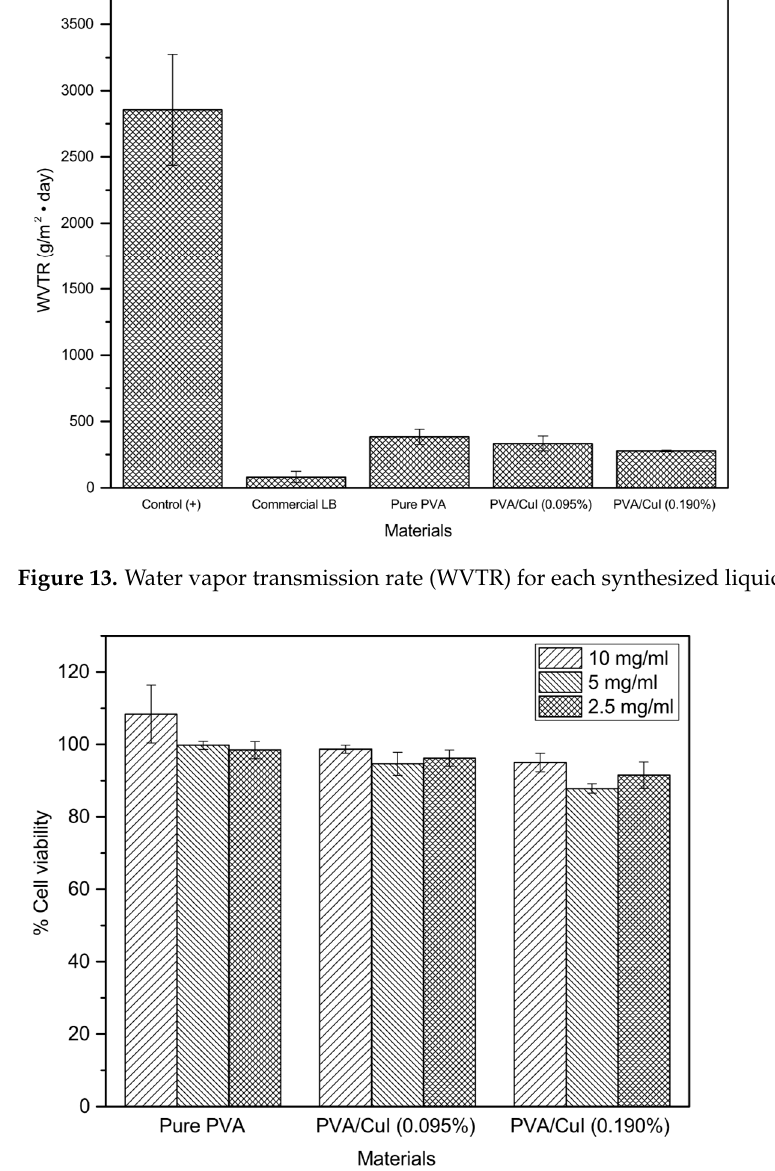
Figure 14. Surviving cells after treatment with each sample